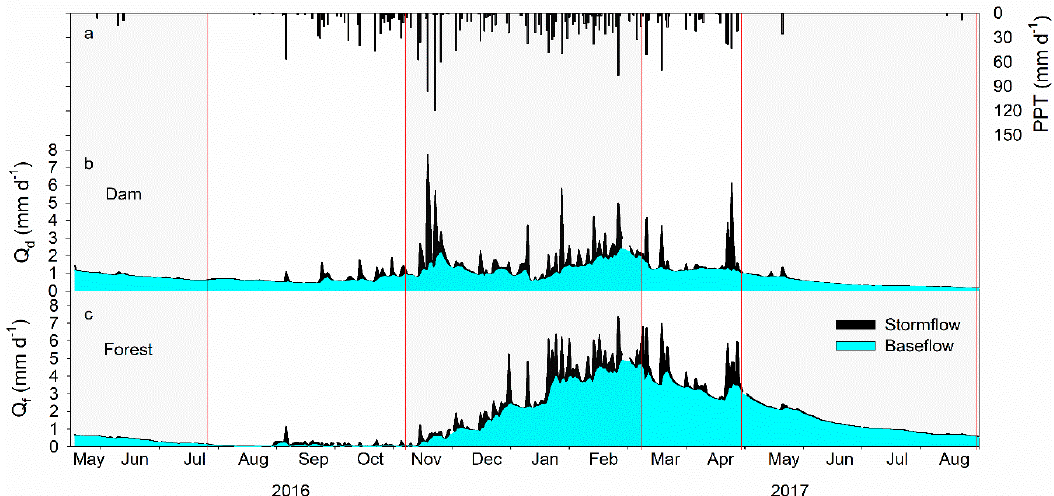
Figure 2. Daily variation of precipitation ( a ) and discharge in two headwater catchments (Q d for the Dam ( b ), and Q f for the Forest catchment ( c )) at the research site. The graphs show data from May 2016 to August 2017 and the red vertical lines indicate sampling campaigns.